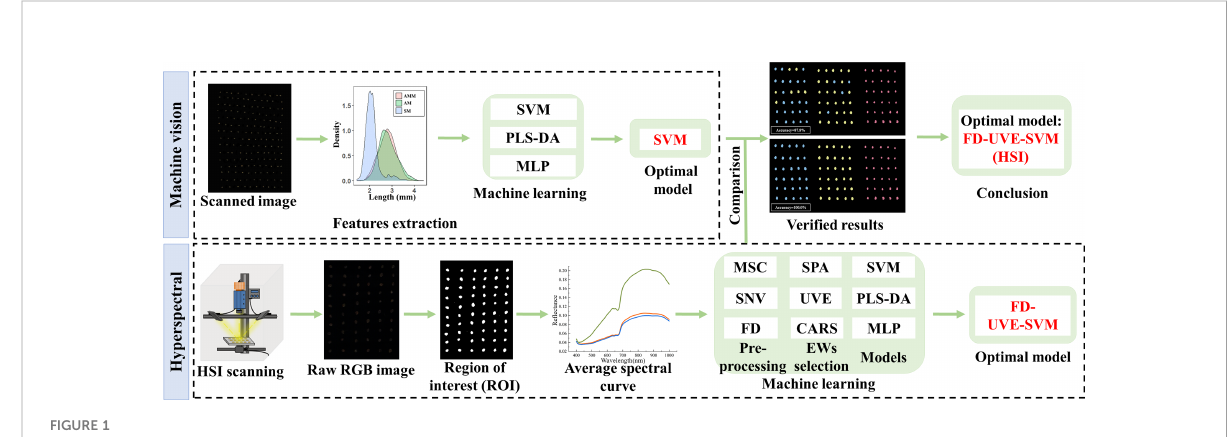
FIGURE 1 Technical